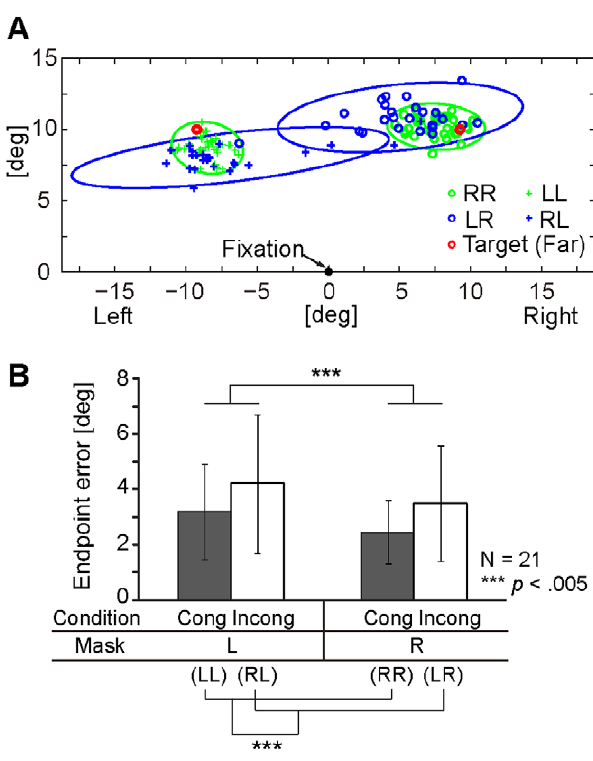
Figure 4. Endpoint error induced by implicit motor control. (A) Endpoint distribution of a single participant and its 95% confidence ellipse in each condition of the far target. Green open circles and crosses respectively denote RR and LL (prime-mask congruent) conditions; blue open circles and crosses respectively denote LR and RL (prime-mask incongruent) conditions. Red open circles indicate the locations of target points. (B) Mean endpoint error in each condition. Data from both target positions (i.e., near and far conditions) were pooled. Error bars indicate the SDs of the endpoint errors across participants. Cong and Incong denote congruent-green and incongru- ent-blue conditions, respectively.